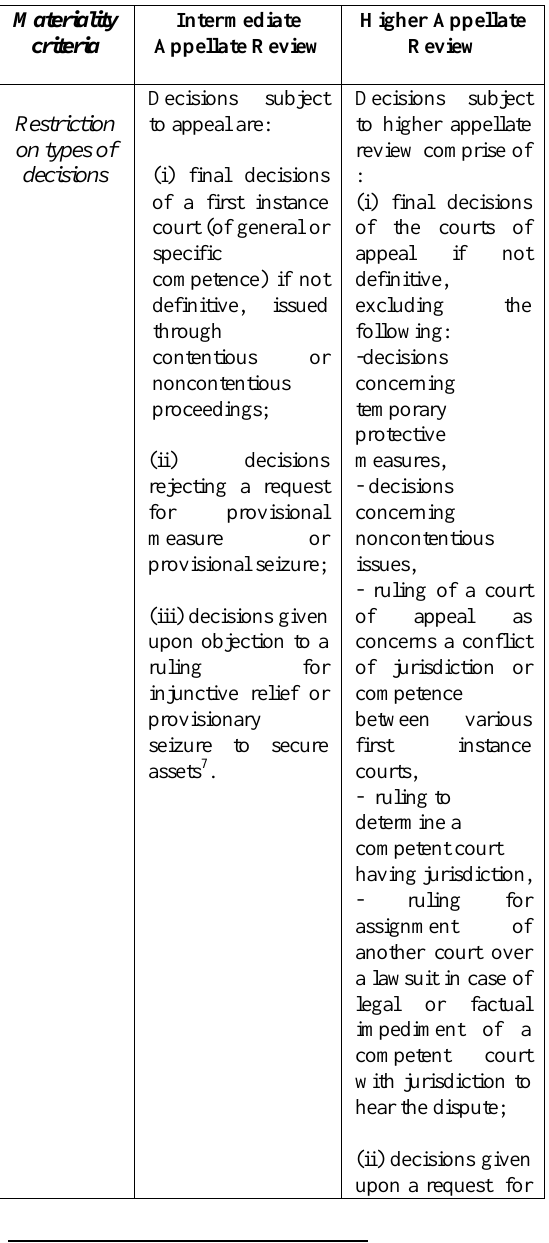
Table 2. Decisions Subject to Intermediate Appellate